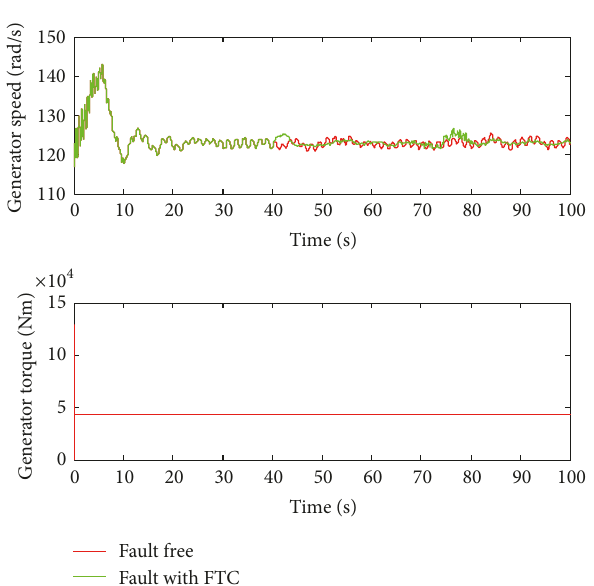
Figure 7: Generator speed and its torque with 𝑓 𝑠 = − 0.2.